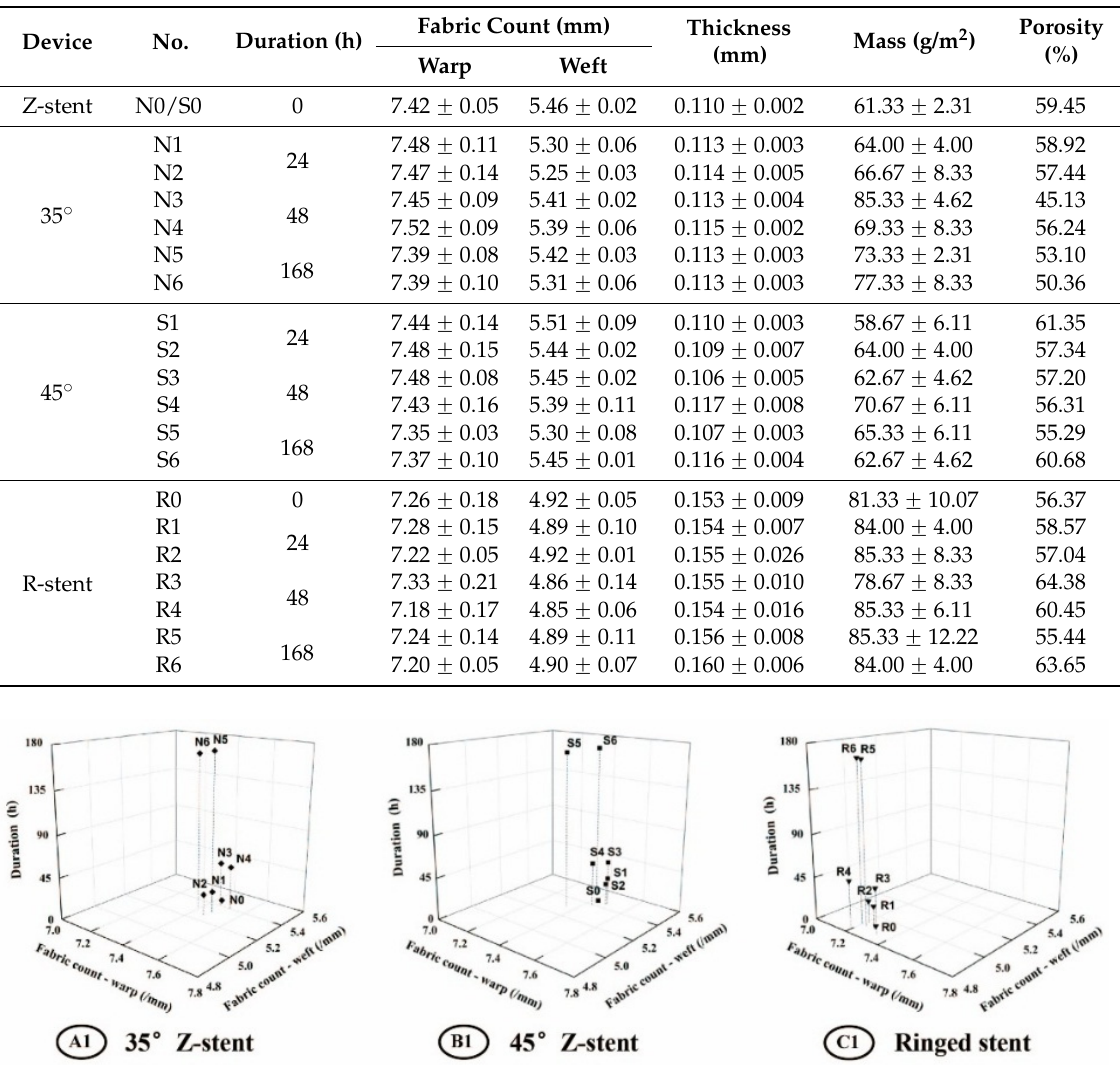
Figure 8. Fabric counts of the fabrics of the stent ‐ grafts. Both the warp and the weft counts decrease slightly after twisting simulation. ( A1 ) 35° Z ‐ stent; ( B1 ) 45° Z ‐ stent; ( C1 ) Ringed stent.